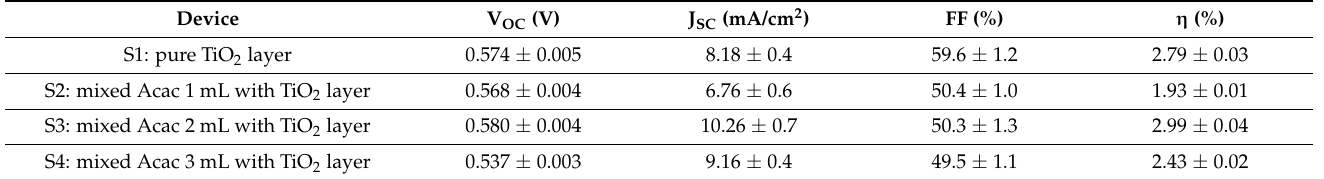
Figure 10. Current–voltage characteristics of the DSSC photovoltaic efficiency for mixed Acac (0, 1, 2, and 3 mL) with a TiO 2 mesoporous layer. Table 2. The DSSC photovoltaic efficiency of mixed Acac (0–3 mL) with a TiO 2 mesoporous layer.